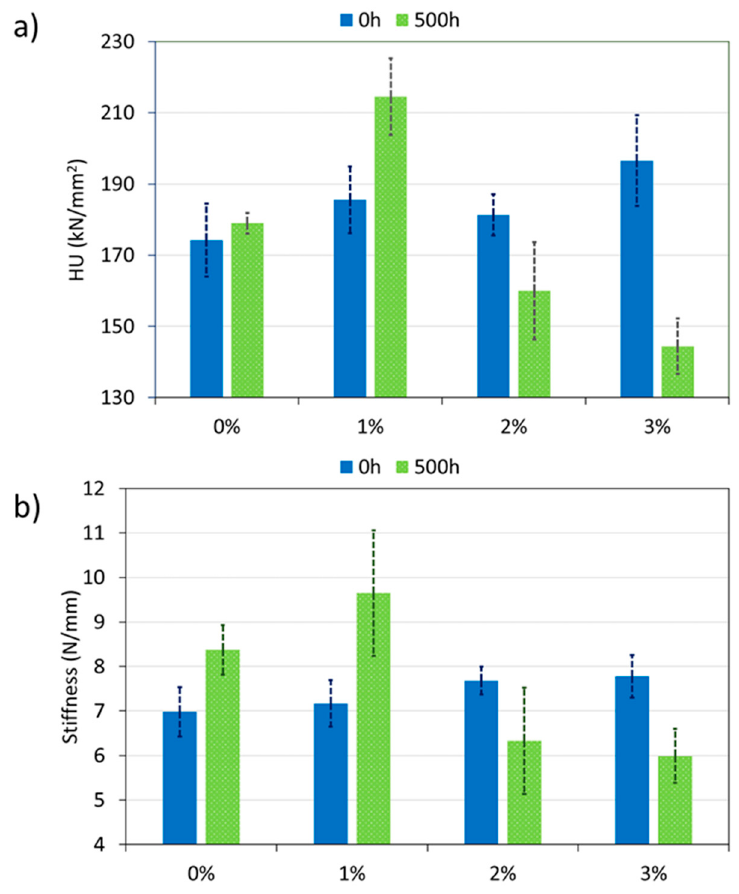
Figure 6. ( a ) Universal hardness (HU) and ( b ) sti ff ness of all organic coatings at 0 and 500 h of exposure.